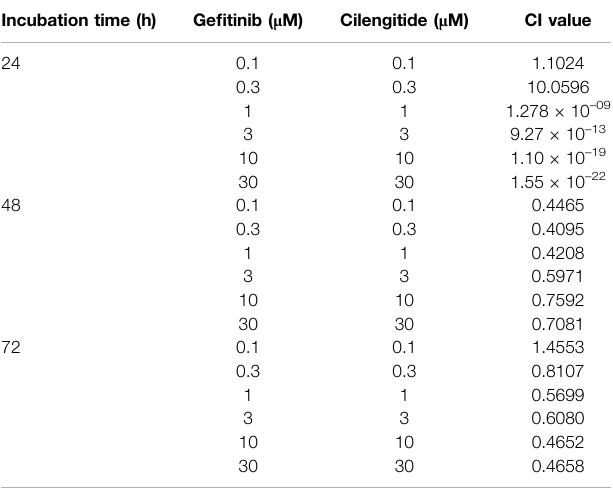
TABLE 1 | Combination index (CI) values for the two-drug combination against A549 cell viability. Incubation time (h)